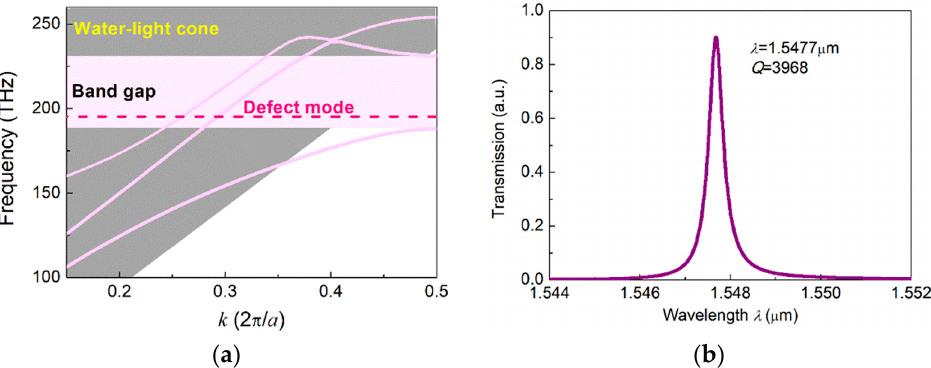
Figure 2. ( a ) The photonic band structure of the larger-center-hole nanobeam photonic crystal cavity. The optical frequency of the defect mode of the designed cavity is also presented in the photonic band gap with dash line. ( b ) The optical transmission spectra of the designed cavity calculated by finite-difference time-domain (FDTD) simulation with resonant wavelength of 1.5477 µ m and Q factor of 3968.